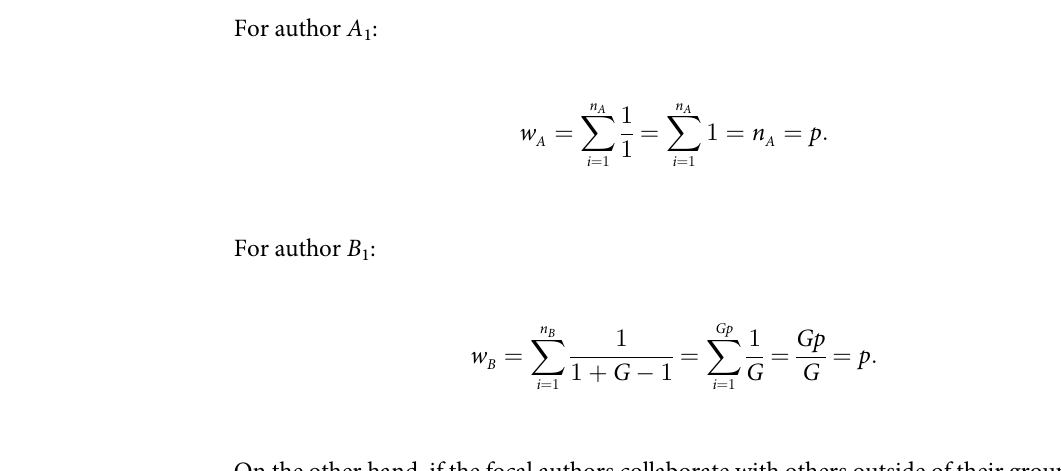
PLOS ONE | https://doi.org/10.1371/journal.pone.0270618 October 26, 2022 4 /